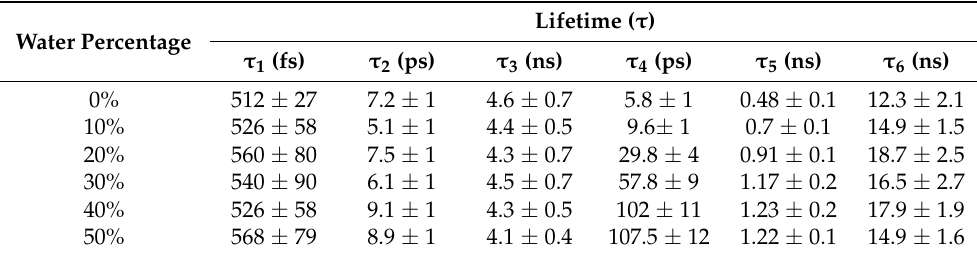
Figure 6. Constructed model for global and target analysis. Table 2. Lifetimes of PDI-III species in THF with different water percentages.